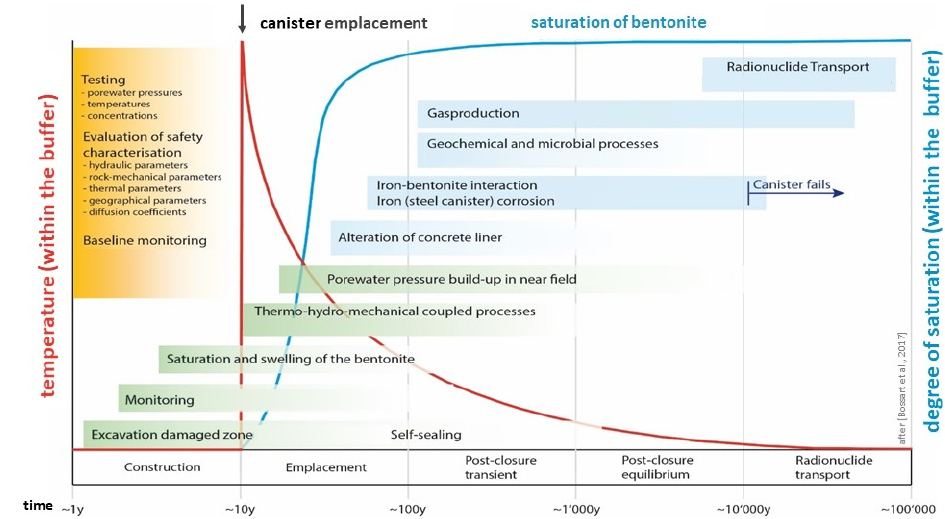
Figure 1. Temporal evolution and implications for a nuclear waste repository after Bossart et al. (2018).